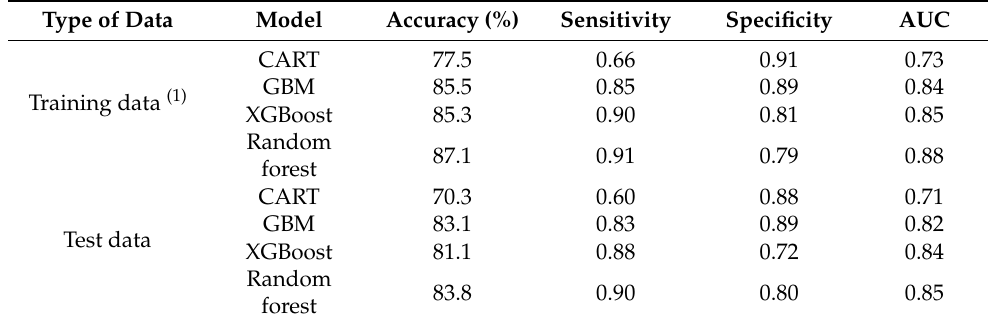
Table 2. The comparison of the accuracy, sensitivity, specificity, and AUC of the ensemble learning- based prediction model for identifying hypokinetic dysarthria.